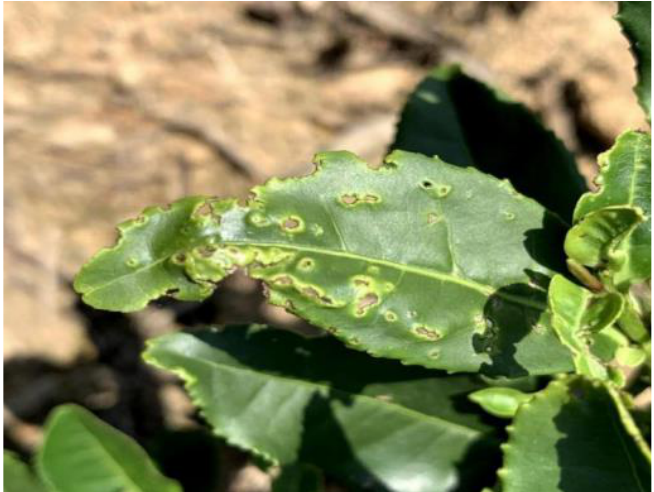
Figure 1. Tea disease caused by Apolygus lucorum.